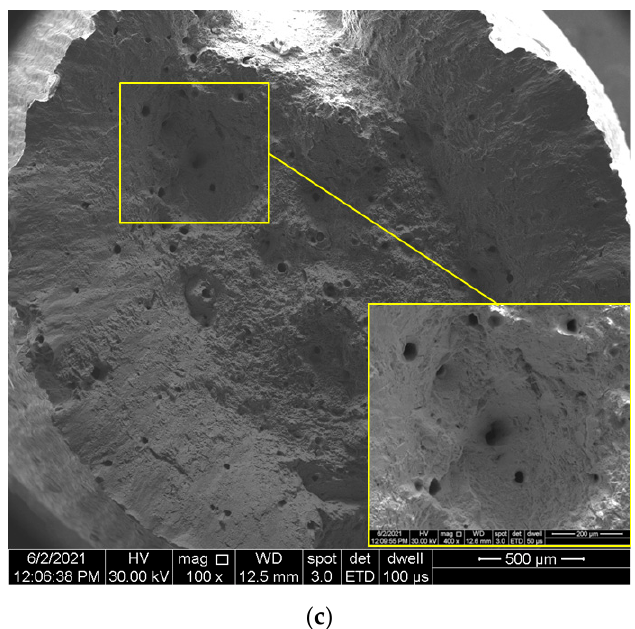
Figure 7. SEM images of the fracture surface of tensile test pieces built with different defocusing distances: ( a ) − 0.5 mm, ( b ) 0 mm, and ( c ) +0.5 mm.